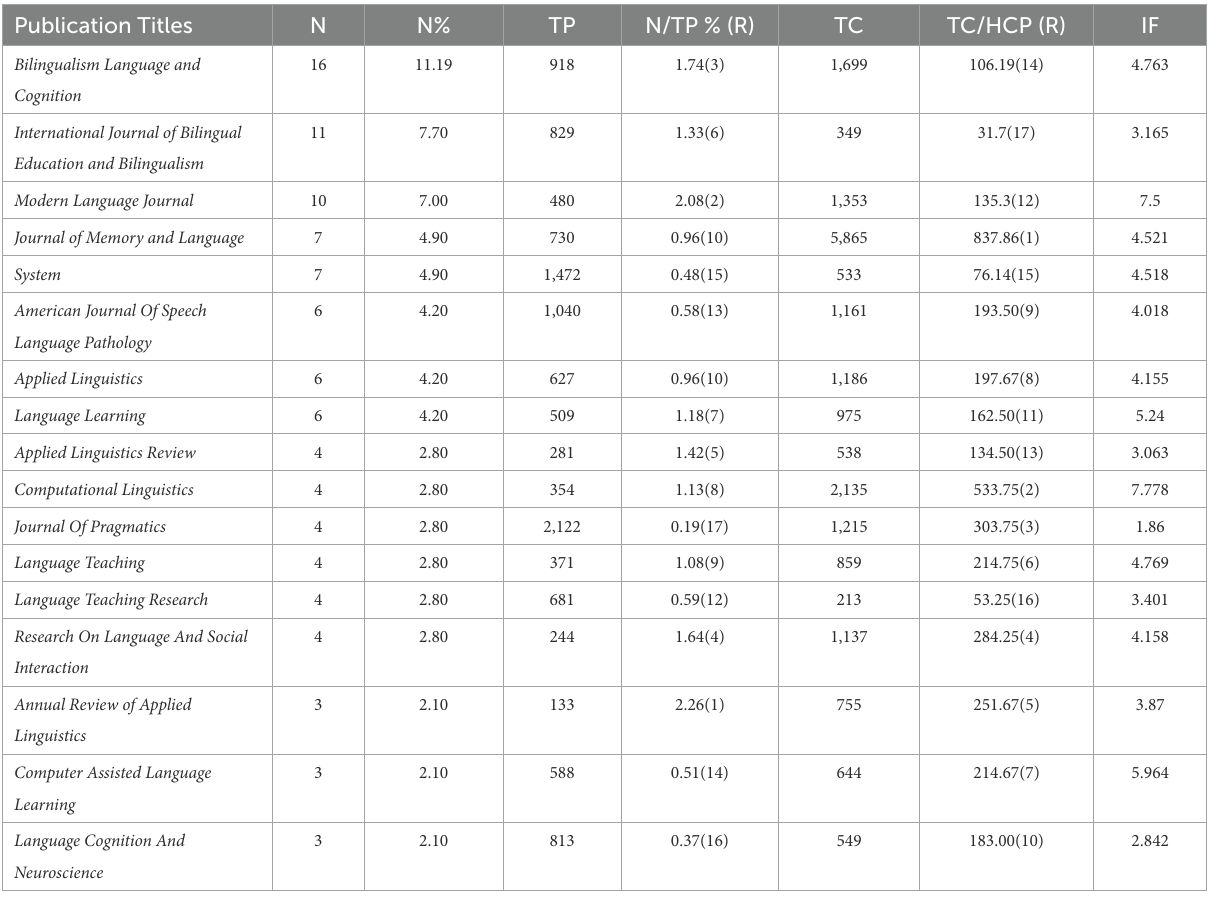
TABLE 2 Top 17 publication venues of